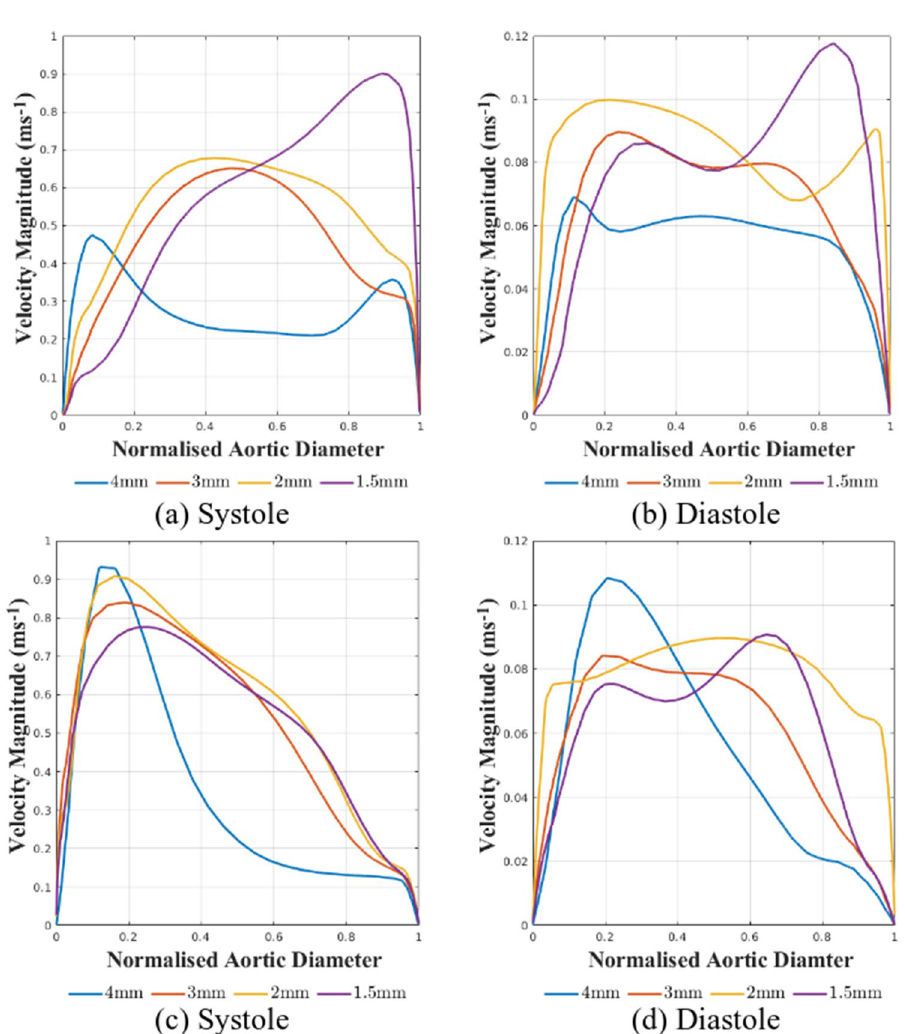
Figure 7. Velocity magnitude along the x-axis ( a , b ) and z-axis ( c , d ) across a slice in the mid-ascending aorta during the systolic and diastolic phases for all CFD simulations based on the four spatial resolutions of 4D-Flow MRI